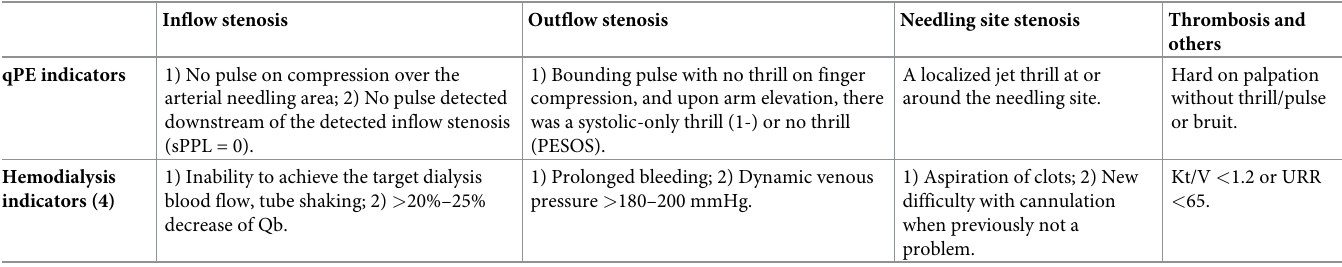
Table 1. Diagnostic elements of the clinical